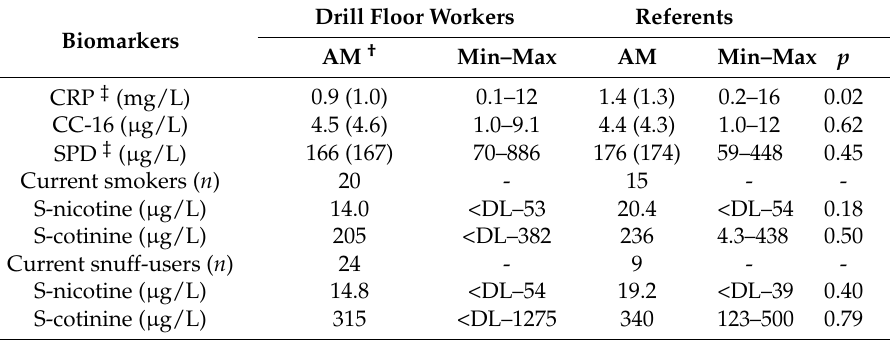
Table 2. The serum concentrations of C-reactive protein (CRP), club cell protein 16 (CC-16), surfactant protein D (SP-D) and nicotine and cotinine at baseline in 65 drill floor workers and 65 referents. Mean concentrations adjusted for age, current smoking habits and BMI are shown in brackets.